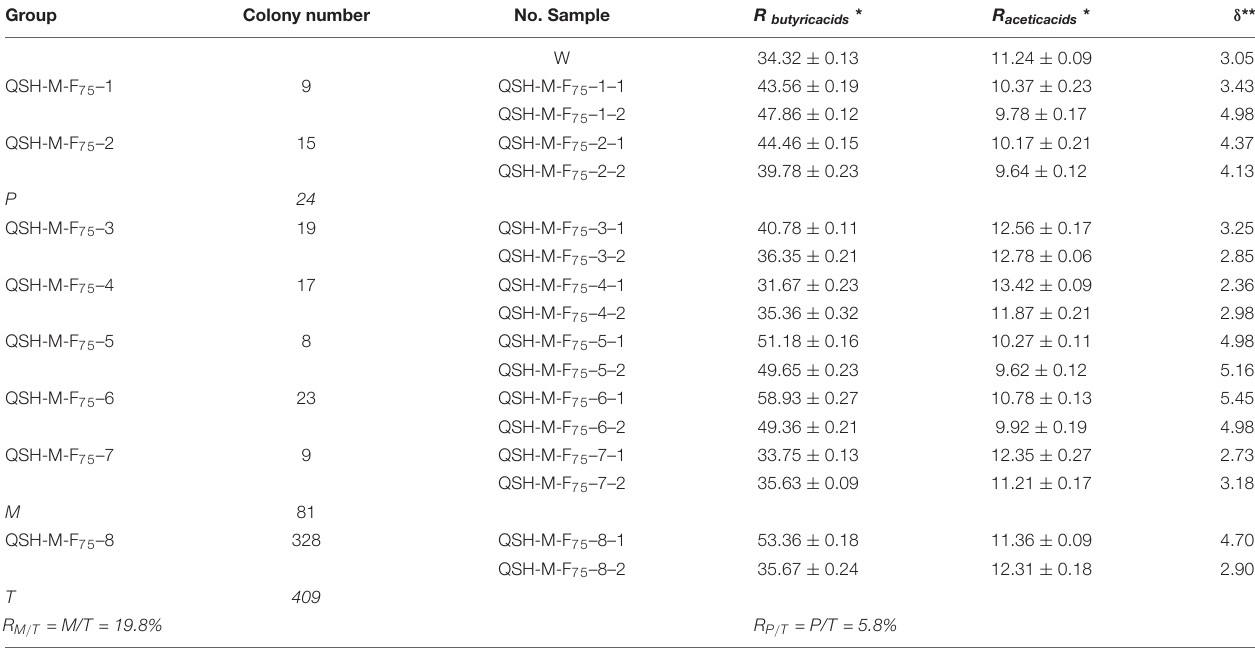
TABLE 3 | Comparison butyric and acetic acid productivity after mutation via 12 C 6 + heavy-ion irradiation with an energy input of 220 AMeV and a dose of 75 Gy at 37 ◦ C, pH = 5.5 and 6.0 during the first 70 h of fermentation ( n = 5). Group Colony